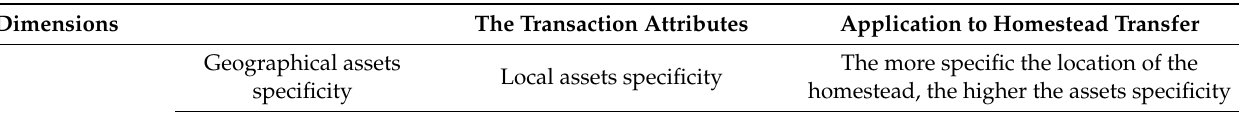
Table 1. The transaction attributes and their application to homestead